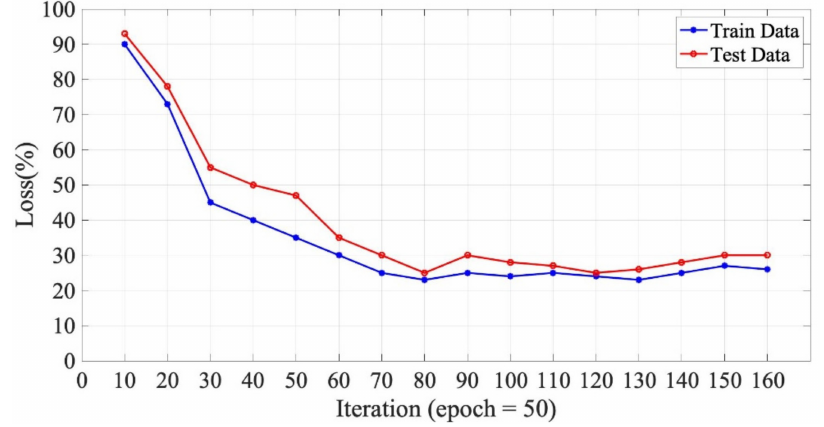
Figure 10. Average iterative accuracy and loss of model training.